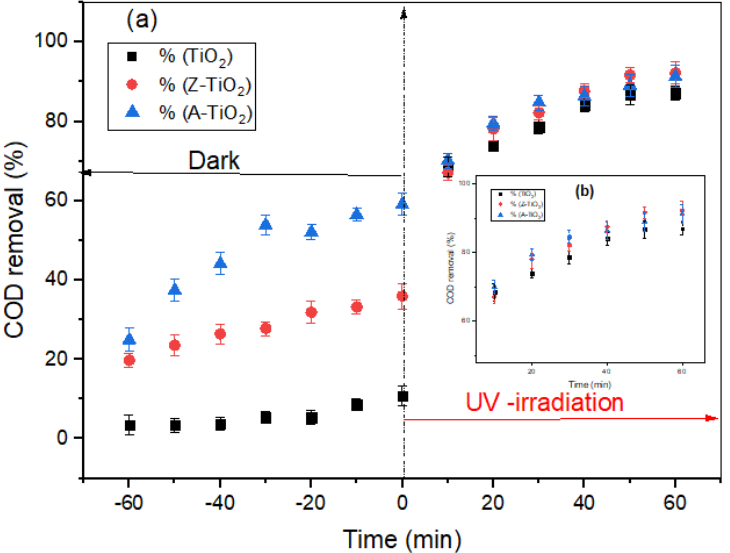
Figure 7. Adsorption ( a ) and photocatalytic ( b ) degradation of COD (367.7 mg/L) at 4 g catalyst loading of TiO 2 (black) < A–TiO 2 (blue) < Z–TiO 2 (red).